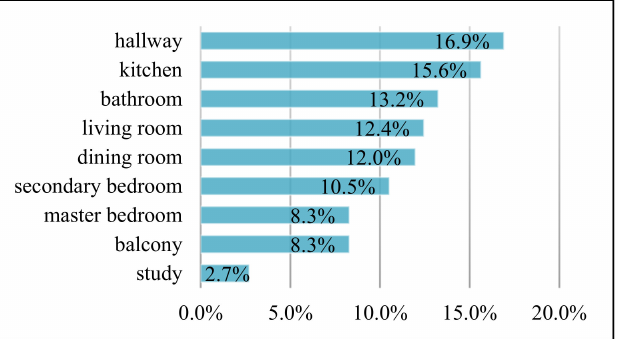
Figure 2. Indoor-space-related issues in cities with a high level of COVID-19 pandemic severity.